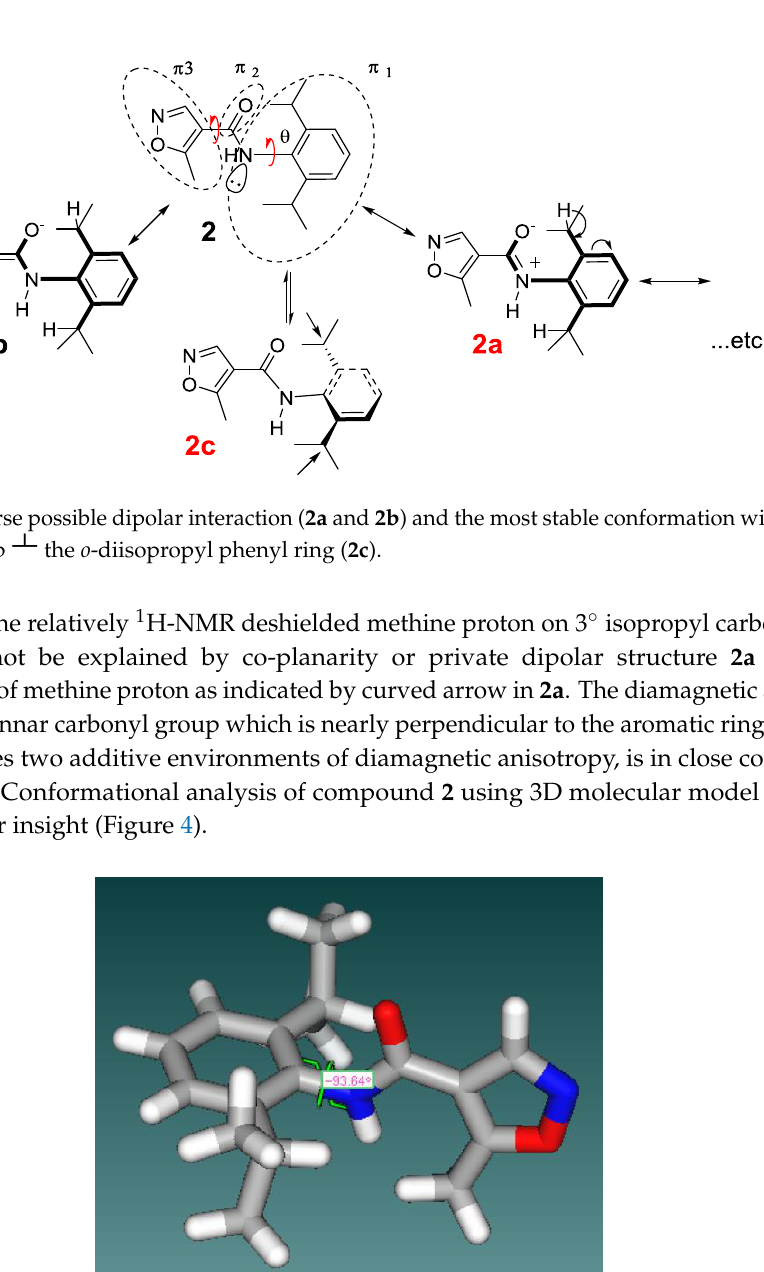
Table 2. Dihedral angle between C=O and phenyl ring, and Dihedral angle between C–O and isoxazole